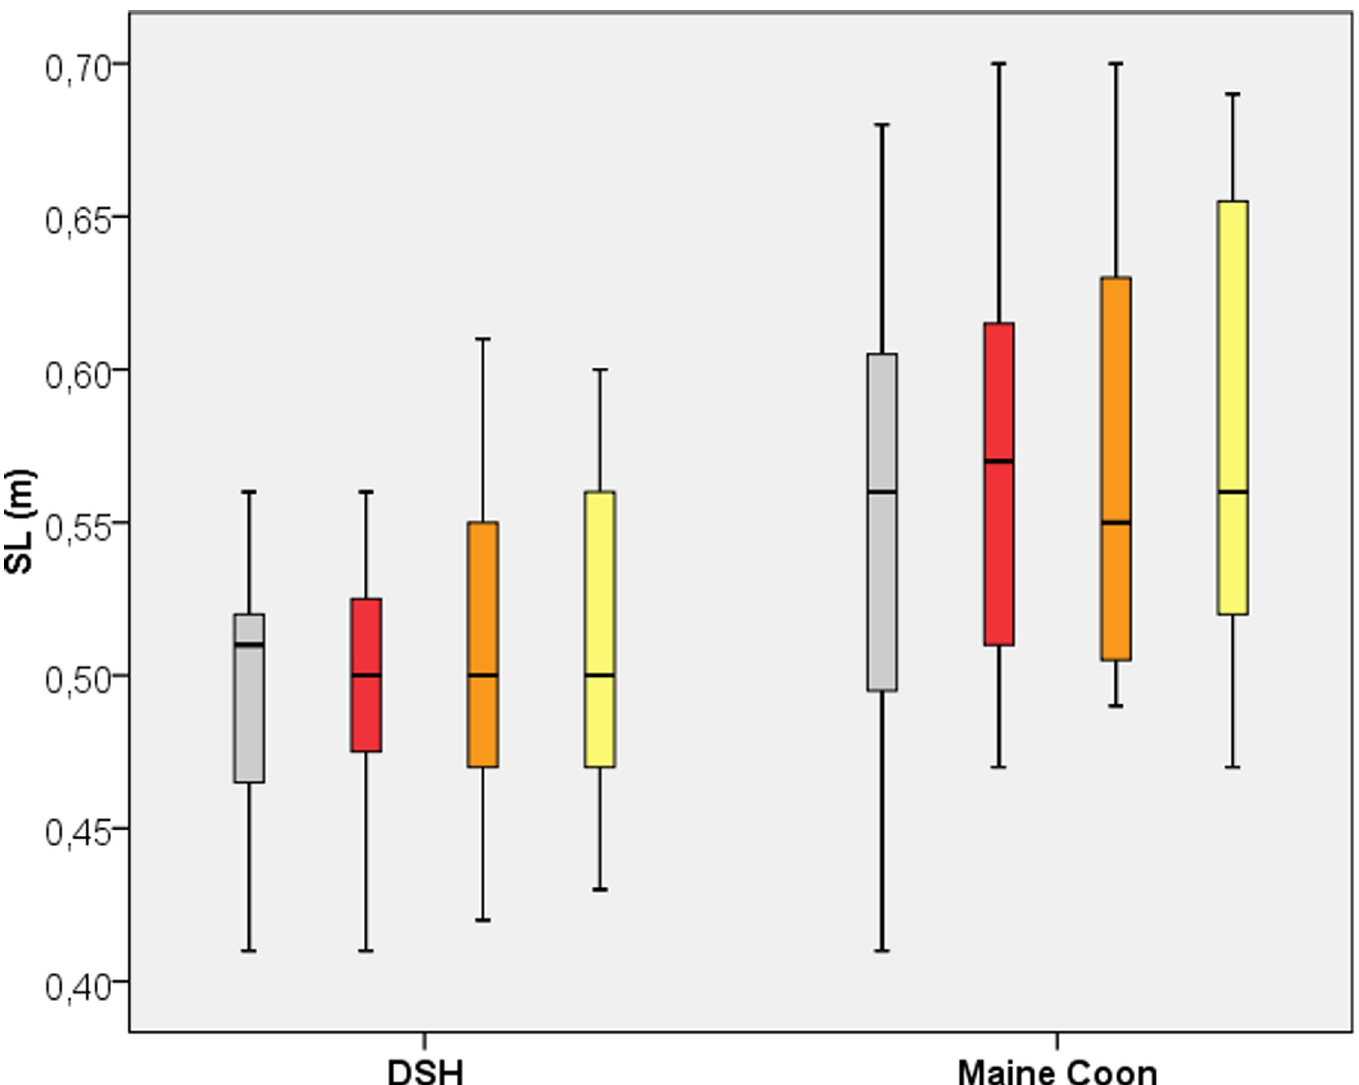
Fig 2. Boxplot of the Step Length (SL) for Domestic Shorthair and Maine Coon Cats. Grey = left forelimb; red = right forelimb; orange = left hind limb; yellow = right hind limb.